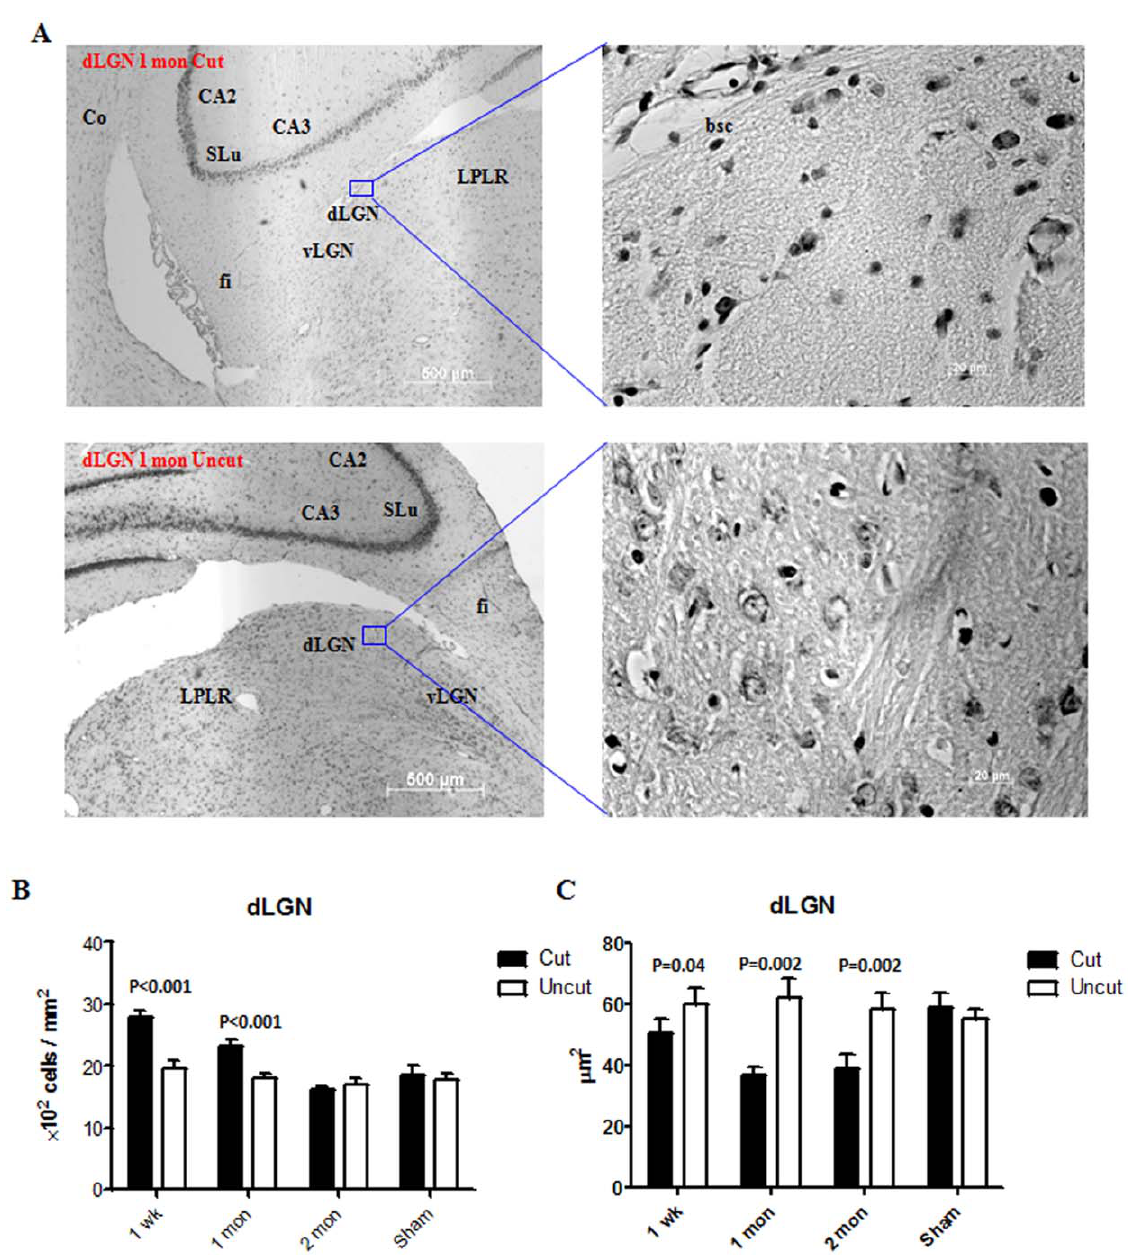
Figure 2. Histological changes in the dLGN. (A) Representative sections (Nissl staining) of the dLGN at month 1 after optic nerve transection. (B) Changes in the cell density in the dLGN from week 1 to month 2. (C) Changes in the cell size (cross-sectional area) in the dLGN from week 1 to month 2. (n=3 for each time point; n=2 for the sham control). Error bars represent SEM. dLGN: dorsal lateral geniculate nucleus; vLGN: ventral lateral geniculate nucleus; LPLR: lateral posterior thalamus nucleus, laterorostral part; fi: fimbria of the hippocampus; CA2: field CA2 of the hippocampus; CA3: field CA2 of the hippocampus; Co: cortex.